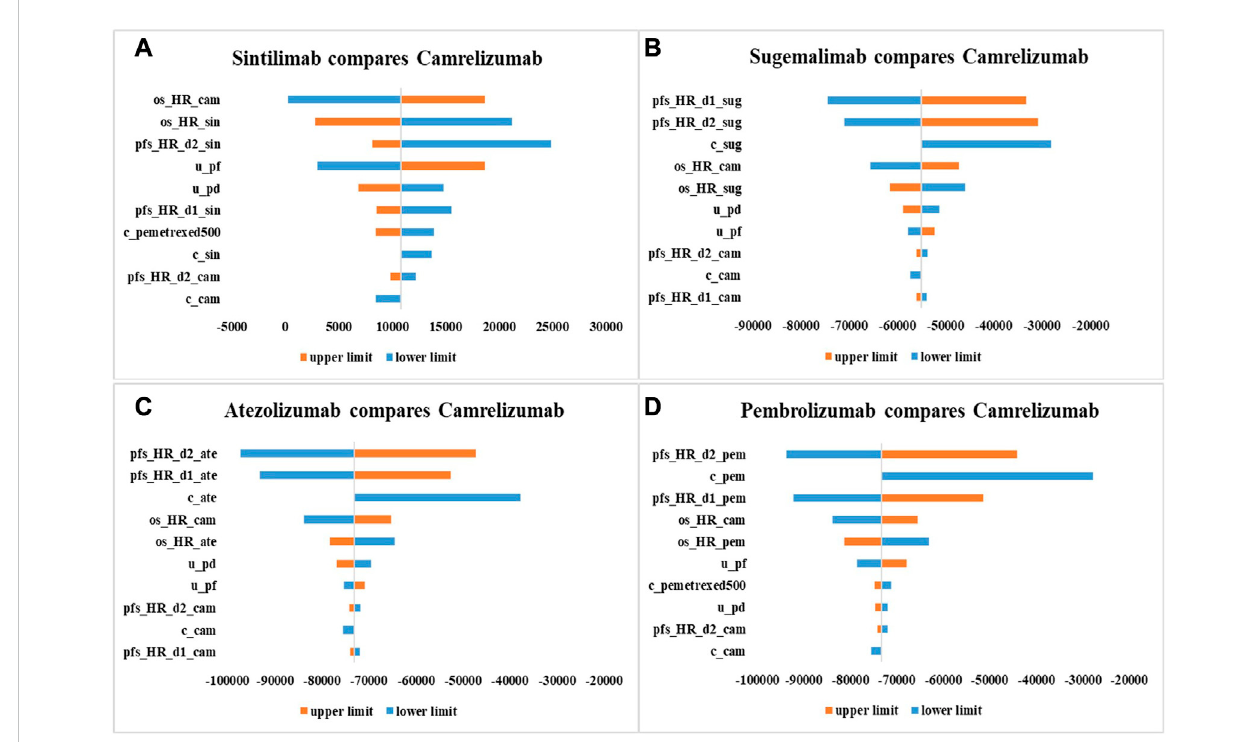
FIGURE 2 One-waysensitivityanalysisresultswith10,000iterationsintheformoftornadodiagram.c_sin,costofsintilimab;c_cam,costofcamrelizumab;c_ sug, cost of sugemalimab; c_ate, cost of atezolizumab; c_pem, cost of pembrolizumab; c_bsc, cost of best supportive care; c_pemetrexed500, cost of pemetrexed(500